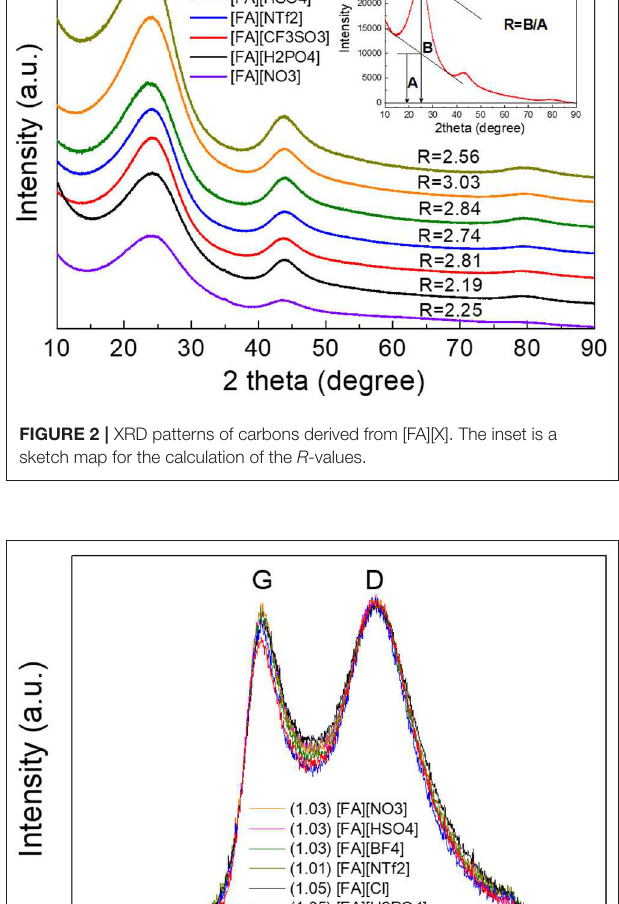
defects) in graphene is centered at 1,342 cm − 1 . The location of the G-band ascribed to sp 2 -hybridized graphitic carbon structure is 1,586 cm − 1 , slightly upshifted as compared to 1,582 cm − 1 observed in graphite (Tuinstra and Koenig, 1970; Nemanich, 1979), which is common for microporous carbons (Tuinstra and Koenig, 1970; Nemanich, 1979; Gonzalez et al., 1992; Liu et al., 1996; Ferrari and Robertson, 2000; Bonino et al., 2005; Qu, 2008; Wang et al., 2009; Martinelli et al., 2011; Zhang et al., 2015d,f). The intensity ratios of D to G-band (I D /I G ) for all samples are above unit, suggesting the presence of many defects in these carbon materials. Among all samples, [FA][CF 3 SO 3 ]-derived carbon is more amorphous, as suggested by its high I D /I G